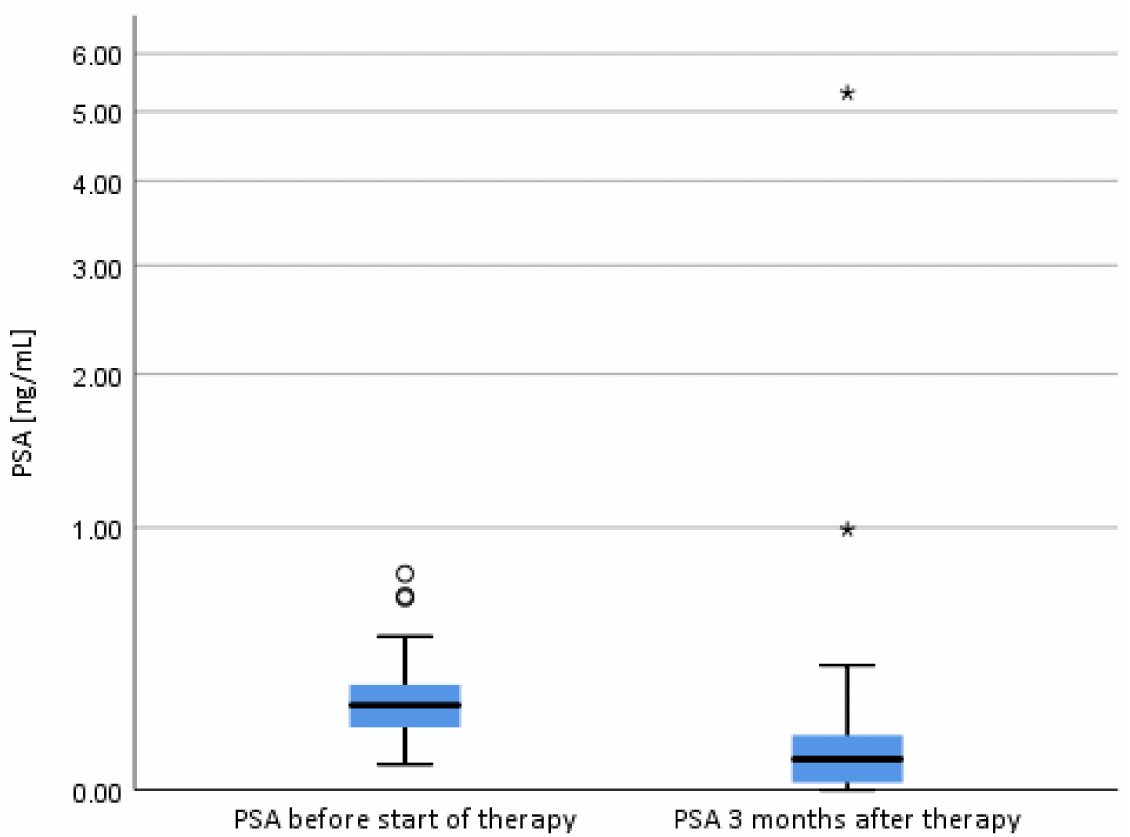
Figure 2. PSA values before therapy and at 3 months Follow-Up (*: 2 patients with biochemical recurrence after 3 months; PSA: prostate- specific